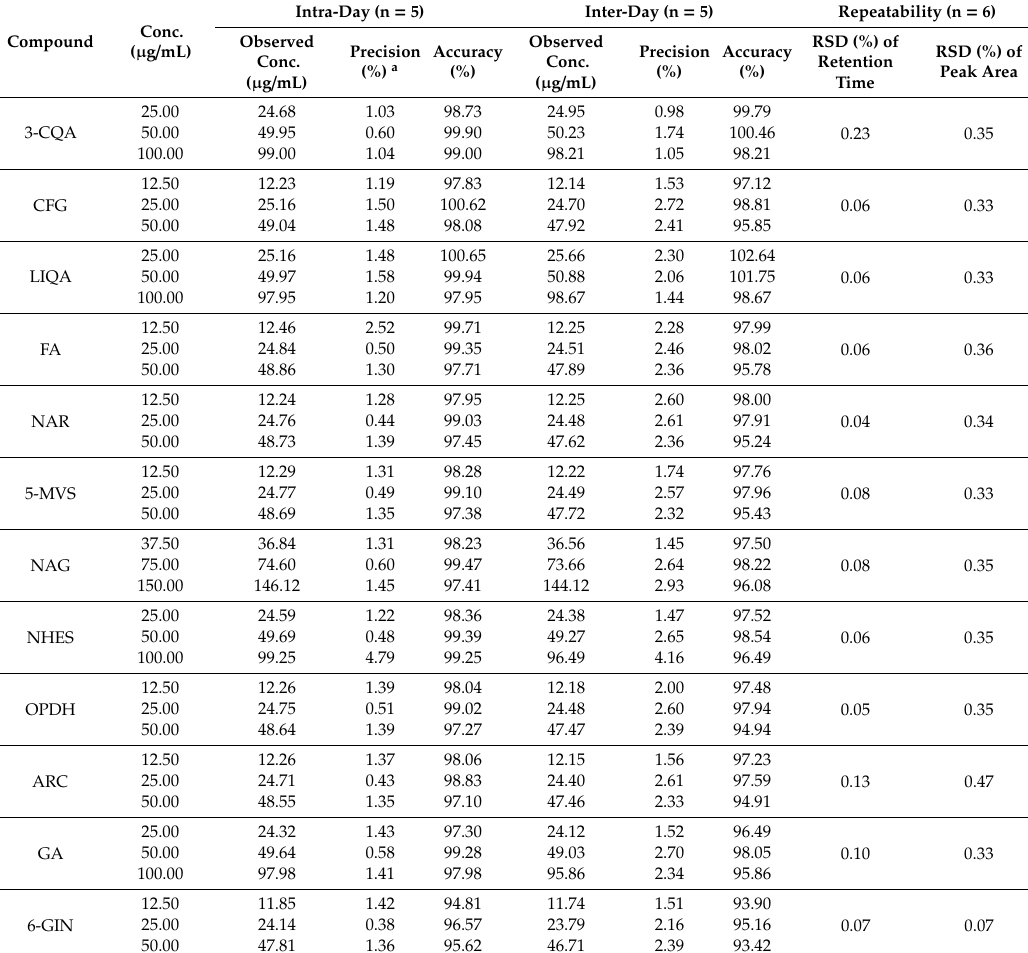
Table 3. Precision assay for 12 marker compounds in YPS using